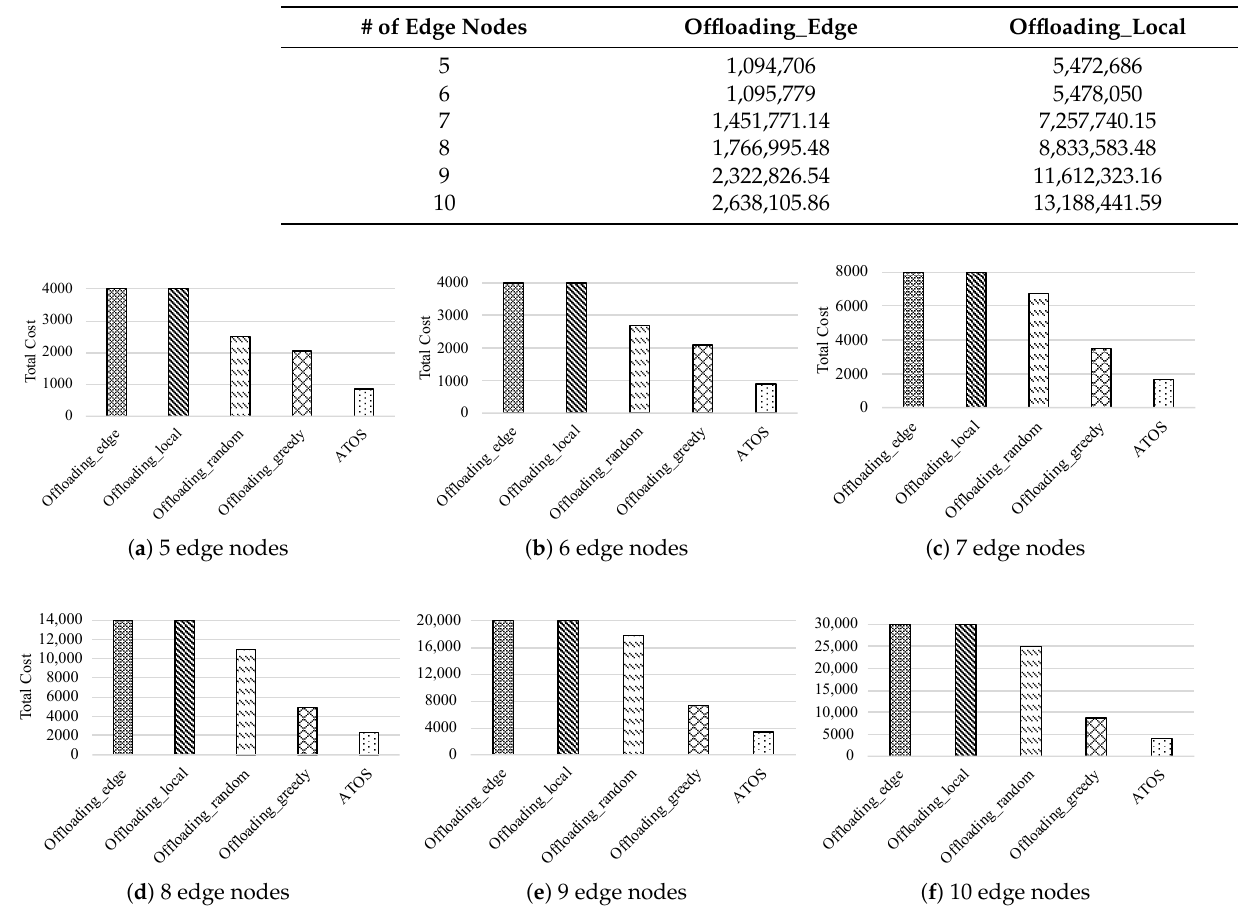
Figure 4. The total cost under different offloading strategies with edge nodes ranging from 5 to